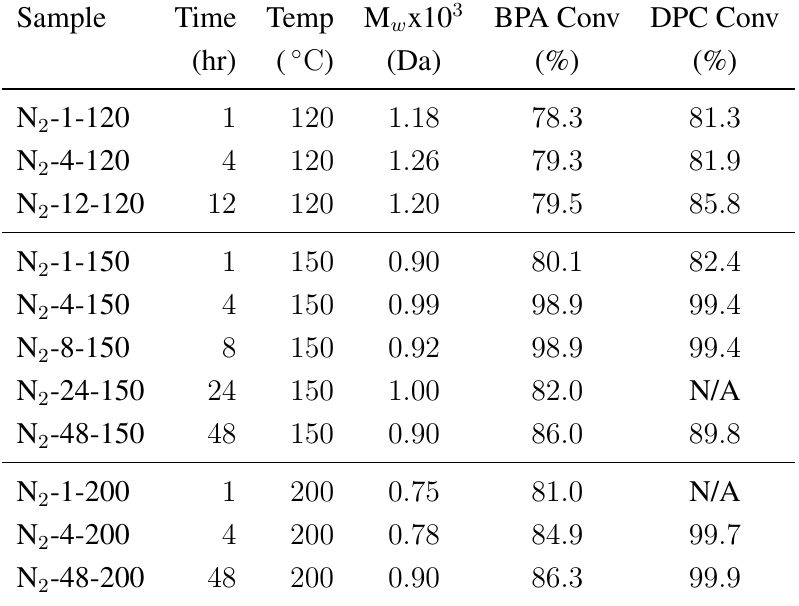
Table 2. PC synthesis in N